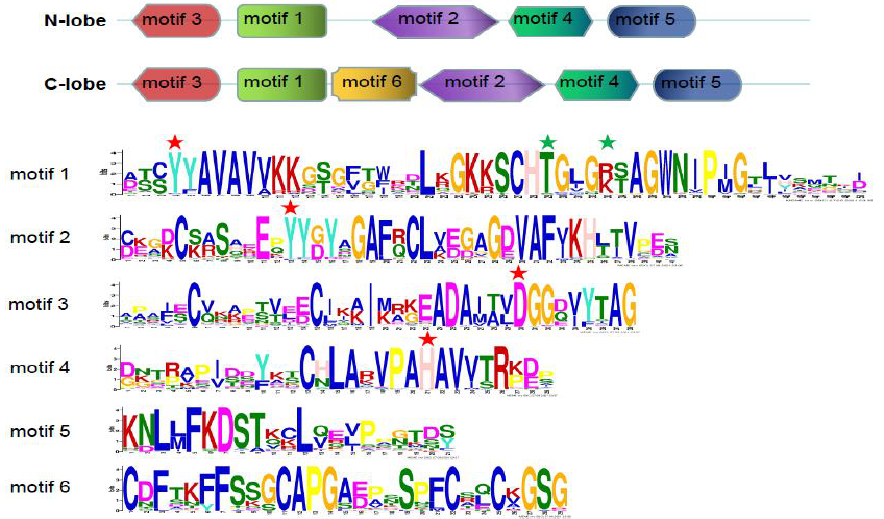
Figure 3. Phylogenetic relationship of N-lobe and C-lobe of TF proteins in 45 fish species. NJ tree was constructed with 1000 bootstrap replicates. Amur stickleback is marked with red asterisks.